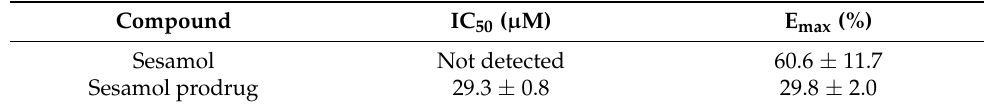
Figure 5. Cytotoxicity of ( A ) sesamol prodrug and ( B ) sesamol in SK-MEL-2 cells at various times. ( C ) Cytotoxicity of sesamol prodrug compared with sesamol prodrug with 1 mM BCH in SK-MEL-2 cells. ( D ) Cytotoxicity of sesamol prodrug compared with sesamol at 96 h in Vero cells. Data are expressed as means ± standard deviations of three replicates. A p -value less than 0.05 is statisti- cally significant. Table 3. Cytotoxicity values of sesamol and sesamol prodrug at 0.5–250 µ M in melanoma SK-MEL-2 cells at 96 h.